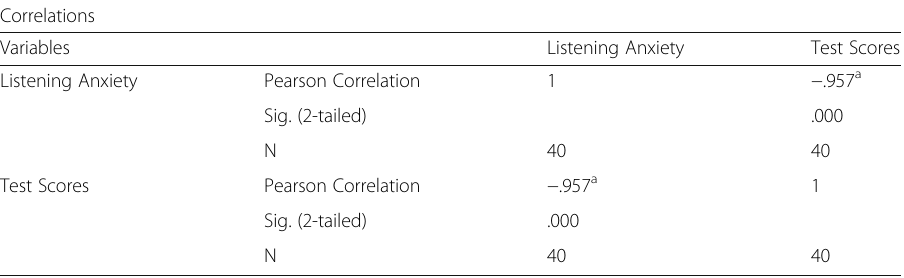
Table 5 The relationship between Listening Test Achievement and FLLAS Correlations Variables